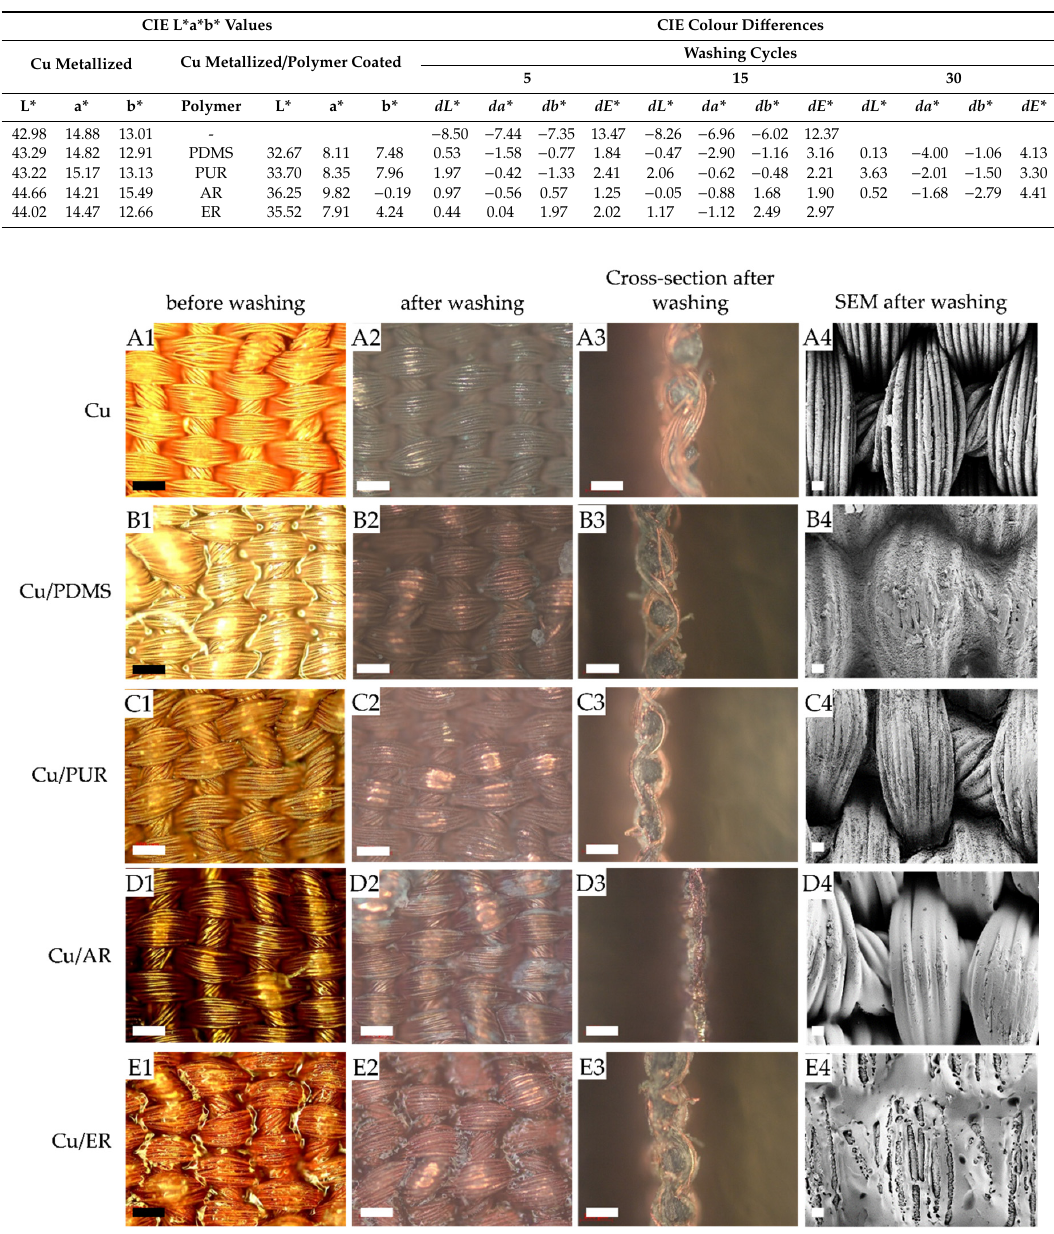
Table 4. CIE values of samples and di ff erences between Cu metallised / protected non-washed and washed samples (up to 30 cycles). CIE L*a*b* Values